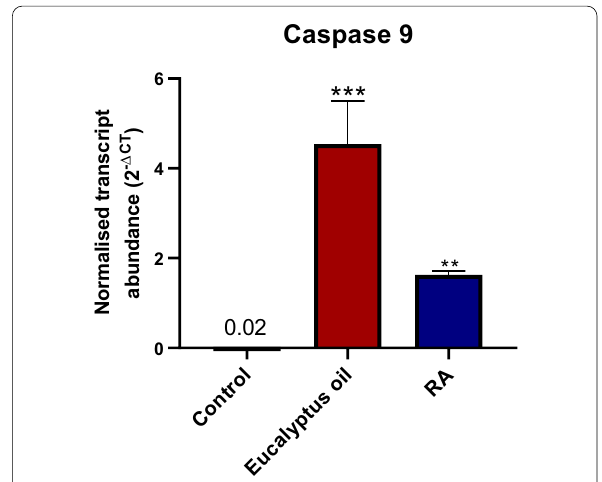
Fig. 5 Effect of EU and RA on gene expression levels for Caspase‑9